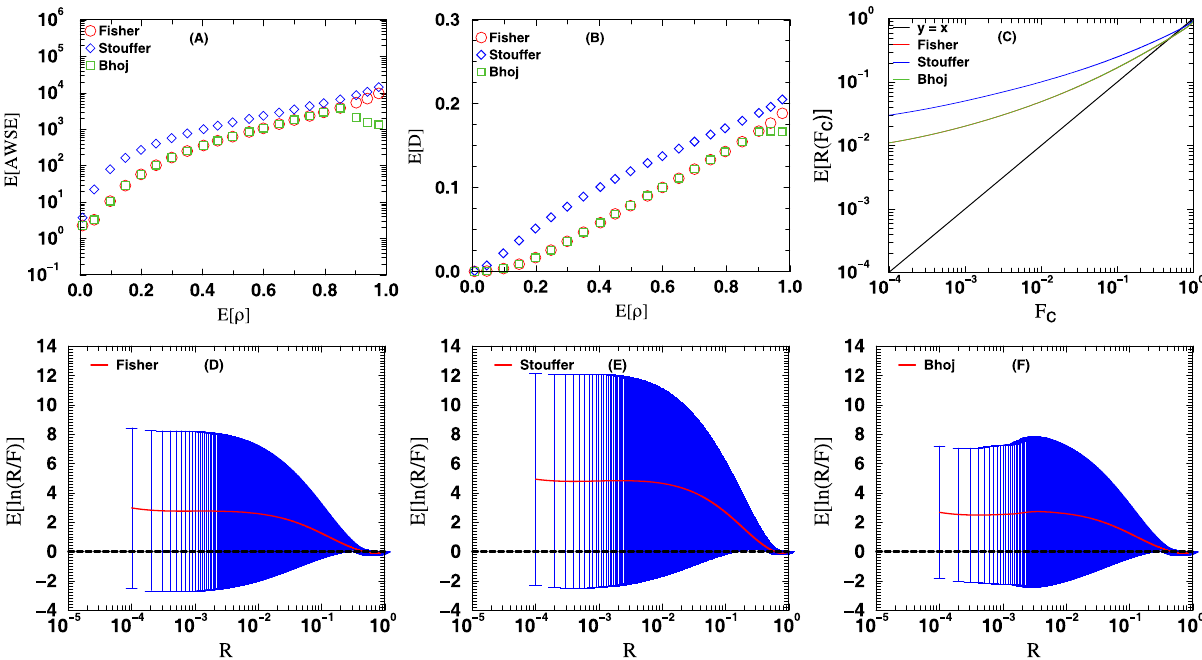
Figure 3. Methods that combine independent P -values: Fisher, Stouffer and Bhoj. The curves plotted above are the curves for the four different measures used to evaluate the accuracy of the computed P -value from combining the P -values of 12 P - value vectors.In panel C, note that the Fisher curve (red) is almost completely covered by the Bhoj curve (green). See text for more details.